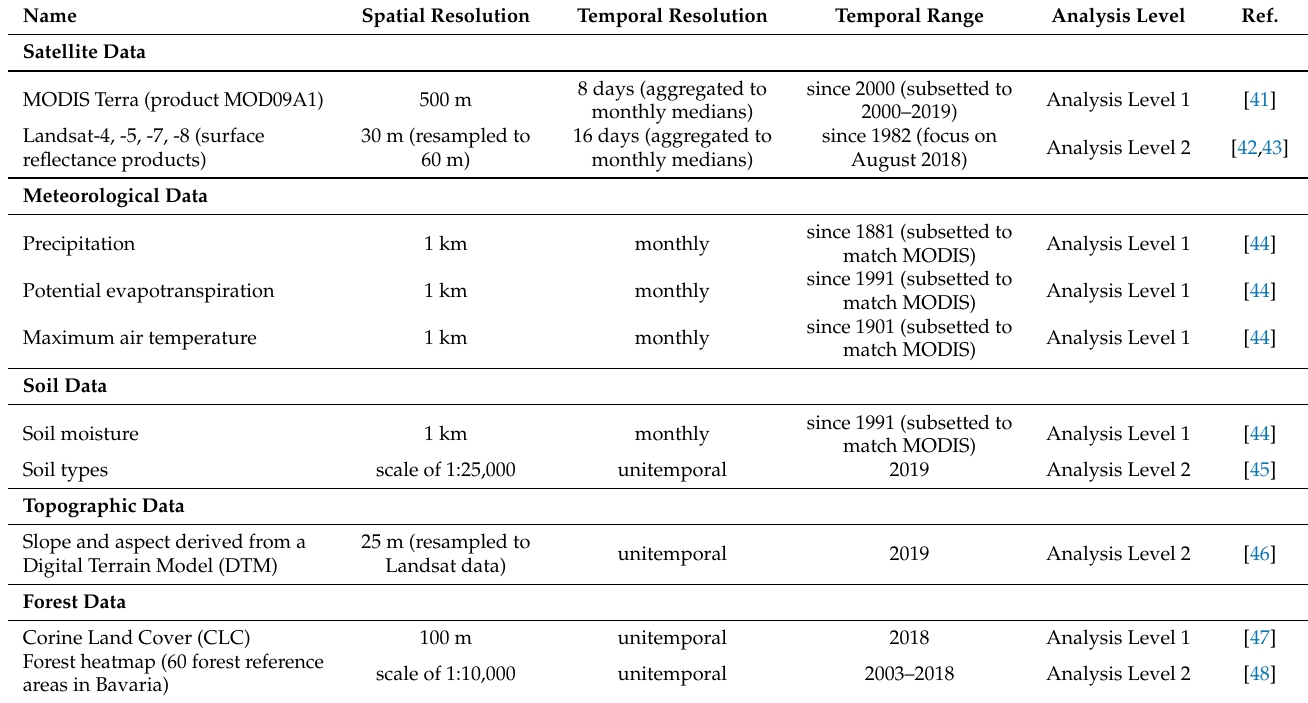
Table 1. Name, spatio-temporal resolution and temporal range of applied data and the associated analysis level during this